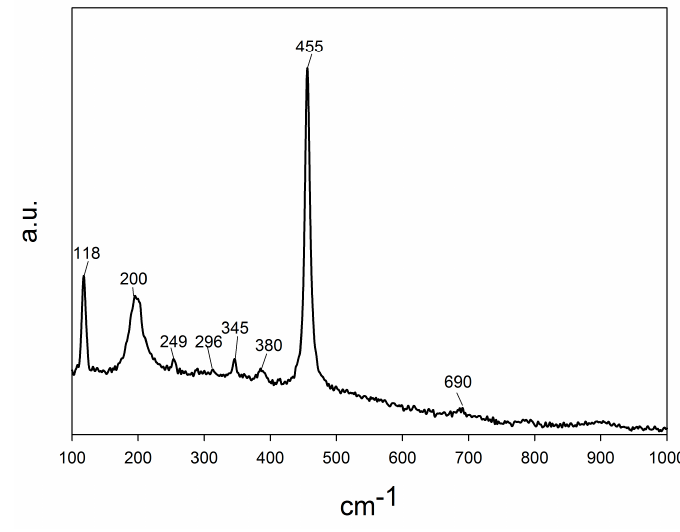
− 1 ) of first 40 cm of the CIM